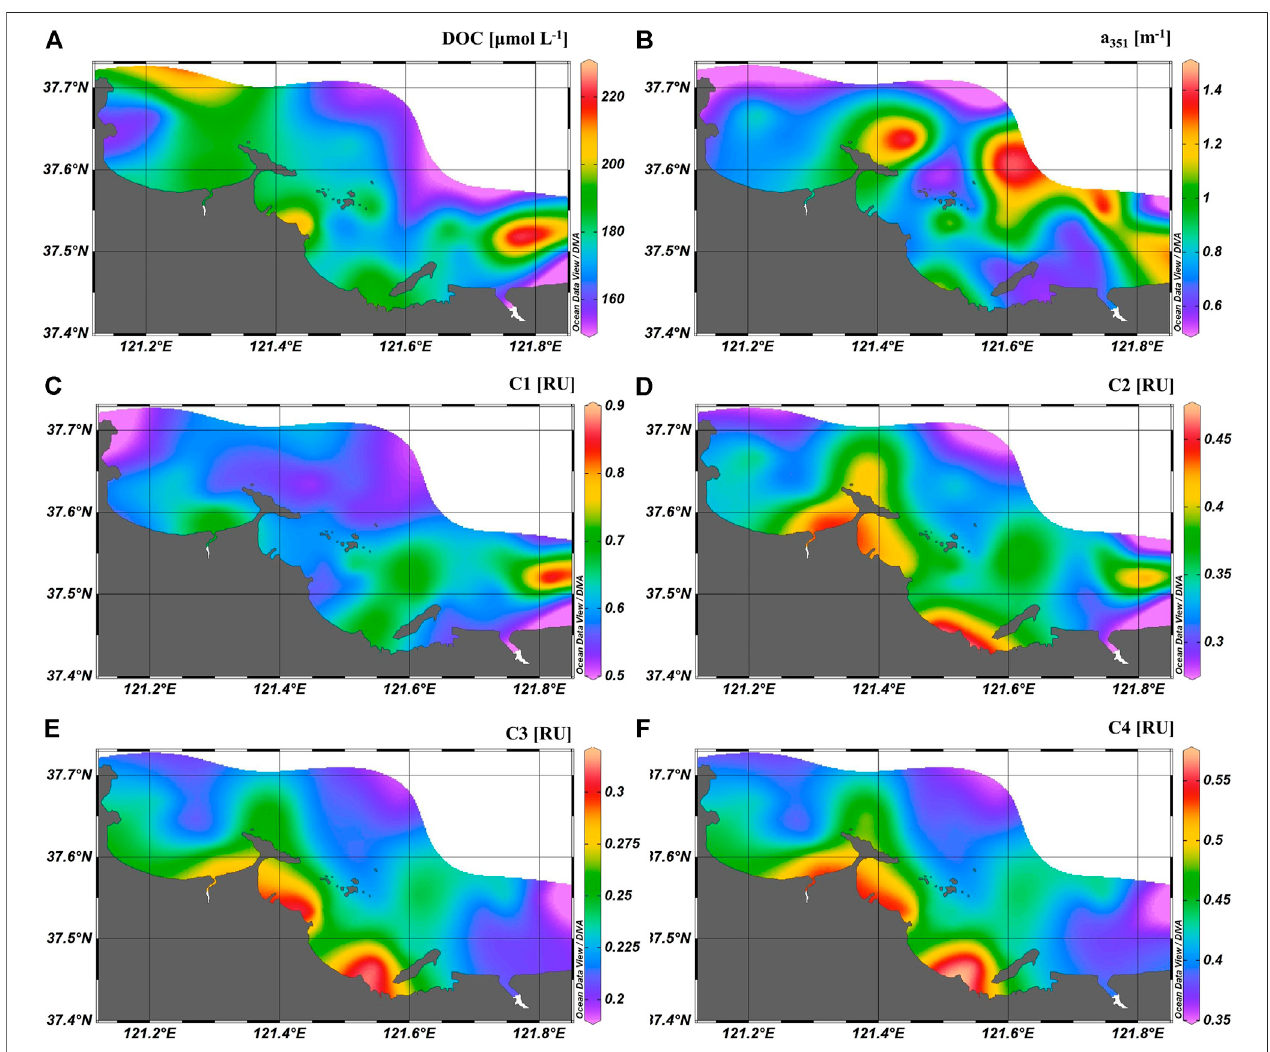
FIGURE6| SurfacedistributionofDOMabundanceinSishiliBayandTaoziBay. (A) DOC, (B) a 351 , (C) C1, (D) C2, (E) C3,and (F) C4.This fi gurewasmadeinODV using DIVA gridding.